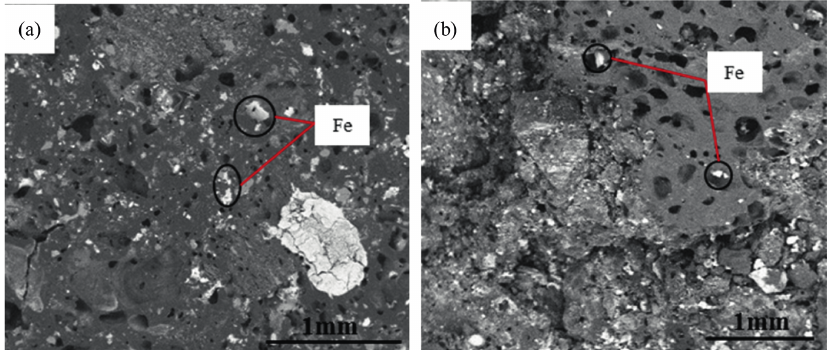
Figure 9: Back scattered electron images of ferro-coke: (a) unreacted; (b)